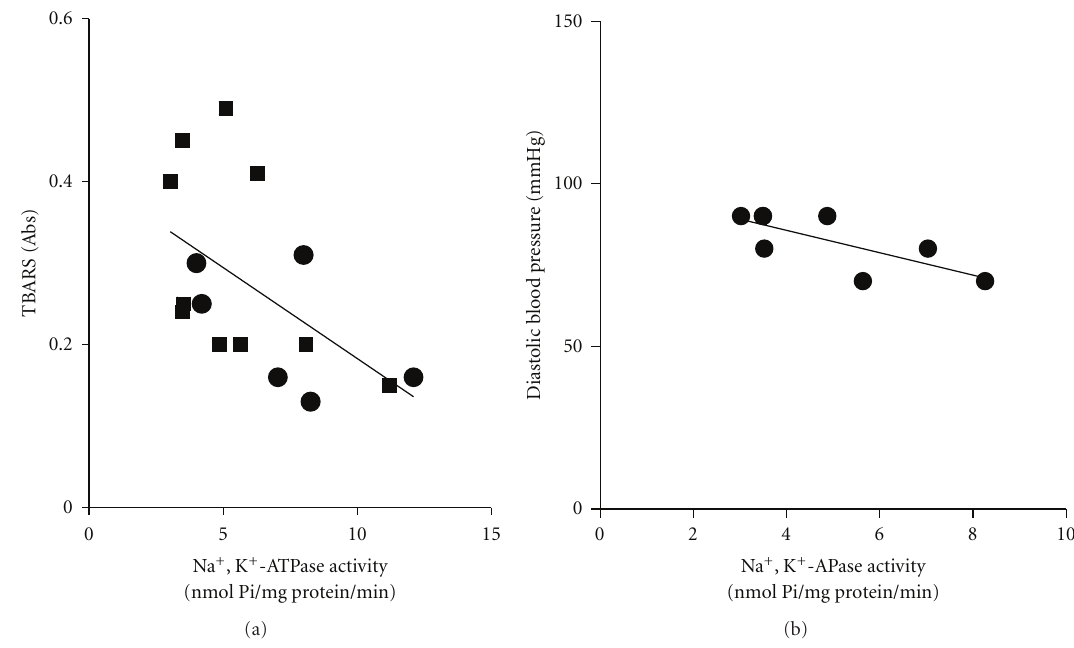
Figure 2: Na + ,K + -ATPase activity (nmol Pi/mg protein/min) negatively correlates with TBARS content only when analyzed with all prehypertensive ( (cid:2) ) and normotensive ( (cid:2) ) subjects ( r = − 0 . 6; n = 16) (a) and diastolic blood pressure only in hypertensive subjects (b). P < 0 . 05 by the Pearson’s correlation coe ffi cient ( r = − 0 . 84; n =